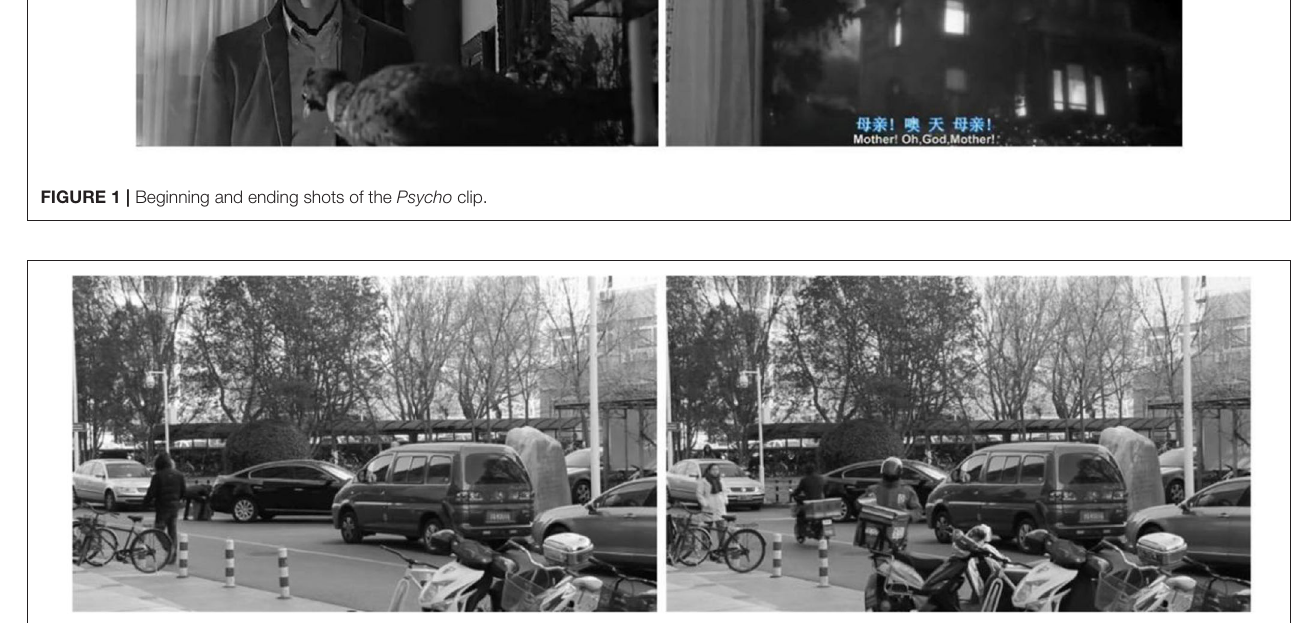
FIGURE 2 | Clip of the street